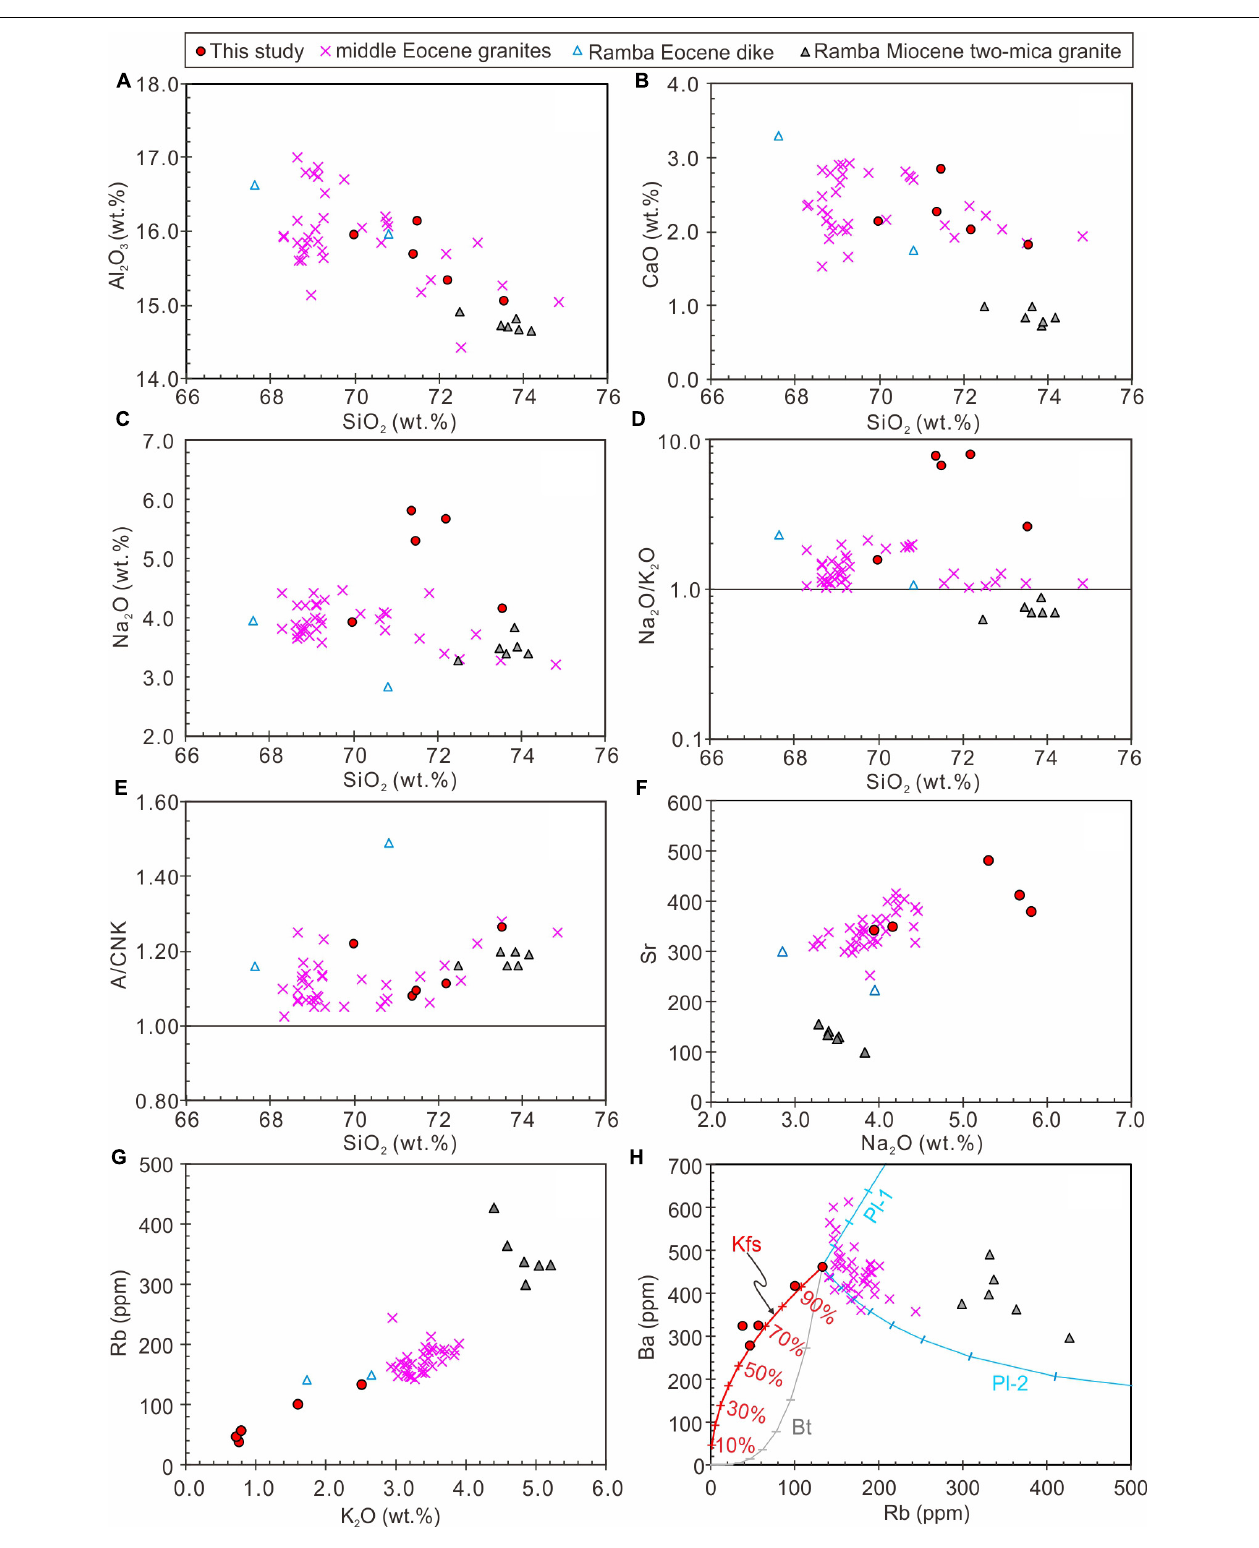
FIGURE 5 | Variation diagrams for selected major and trace elements. Variations of (A) Al 2 O 3 , (B) CaO, (C) Na 2 O, (D) Na 2 O/K 2 O, (E) A/CNK vs. SiO 2 . Variations of (F) Sr vs. Na 2 O, (G) Rb vs. K 2 O, and (H) Ba vs. Rb. The numbers in percent of (H) denote melt fractions. The partition coefficients of Rb and Ba for K-feldspar (Kfs) (Rb: 3; Ba: 2), plagioclase (Pl) (Pl-1: Rb = 0.03, Ba = 0.1; Pl-2: Rb = 0.3, Ba = 1.5), and biotite (Bt) (Rb: 2.5; Ba: 6) are from Laurent et al. (2013). Data sources: middle Eocene granites: Zeng et al. (2011) and Hou et al. (2012); Ramba Eocene dike and Miocene two-mica granite: Liu et al. (2014).